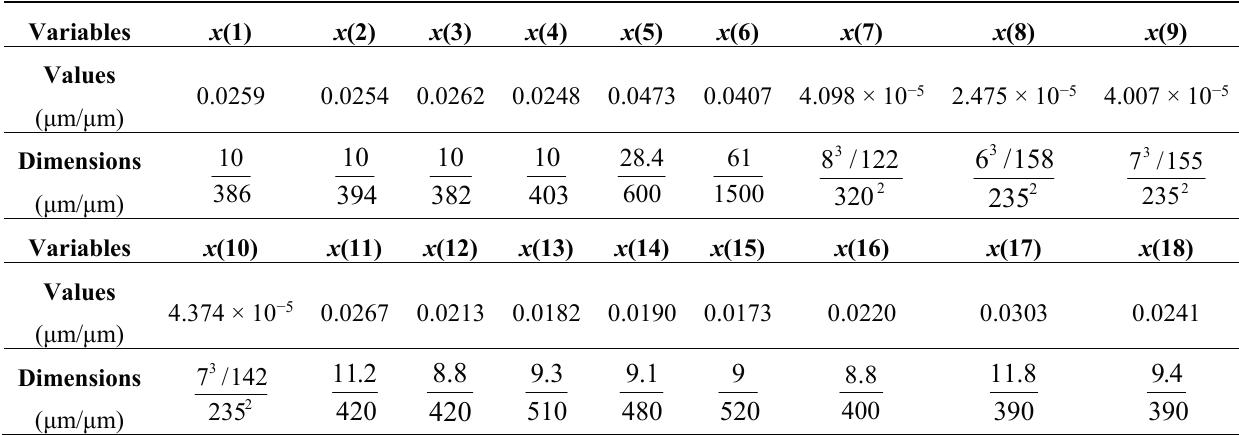
Table 6. The optimized values of the variables and springs